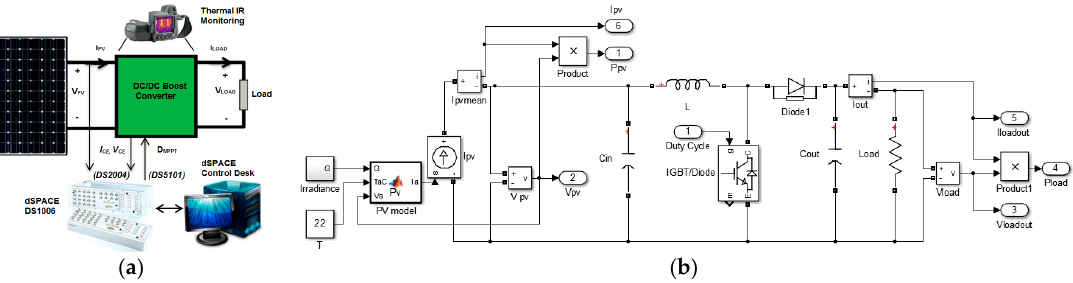
Figure 5. Schematic diagram of ( a ) experimental set-up, and ( b ) boost converter model in Simulink.